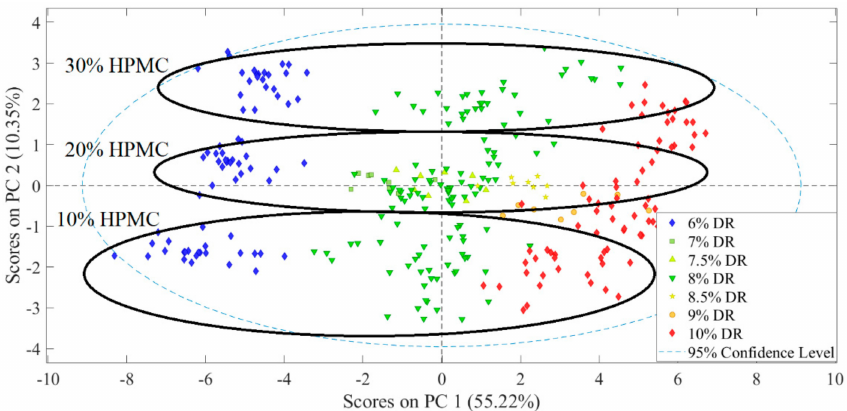
Figure 6. Score plot of preprocessed Raman transmission